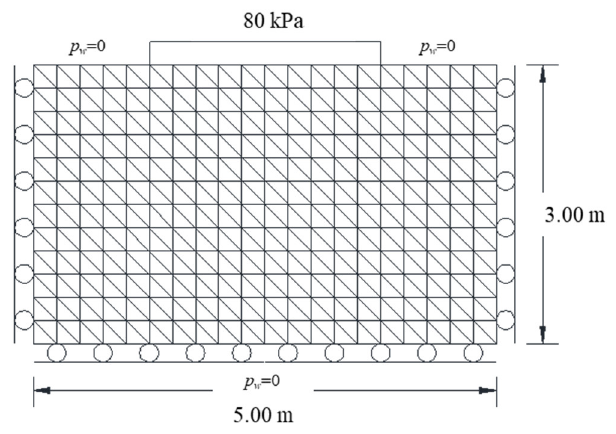
Figure 7. Soil domain under loading by the isolated footing and its boundary conditions. Table 2. Properties of the saturated soil for mechanical analysis of the isolated